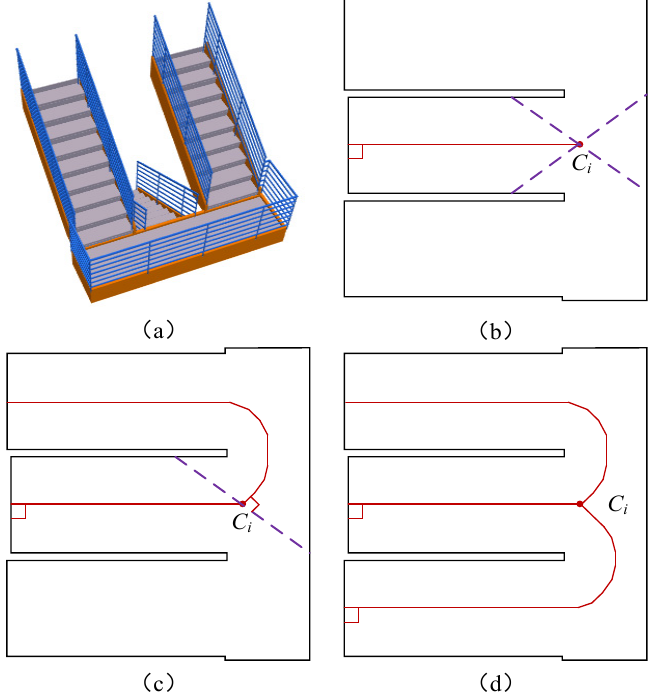
Figure 11. The generation of the X-Z topological path for an m-style stair: ( a ) 3D shape of an m-style stair, ( b ) boundary image of the m-style stair, ( c ) generated X-Z topological path for one stair flight of the upper half stair, and ( d ) final generated X-Z topological path of the m-style stair. According to step 1 and step 2, the endpoint C 1 and the reference line can be selected.